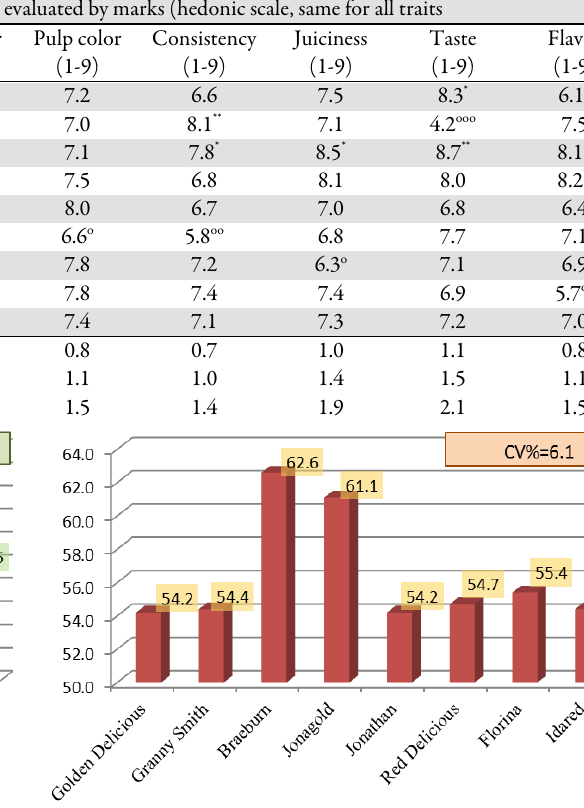
Fig. 6. Overall score for each apple cultivar based on Questionnaire 2 general marks